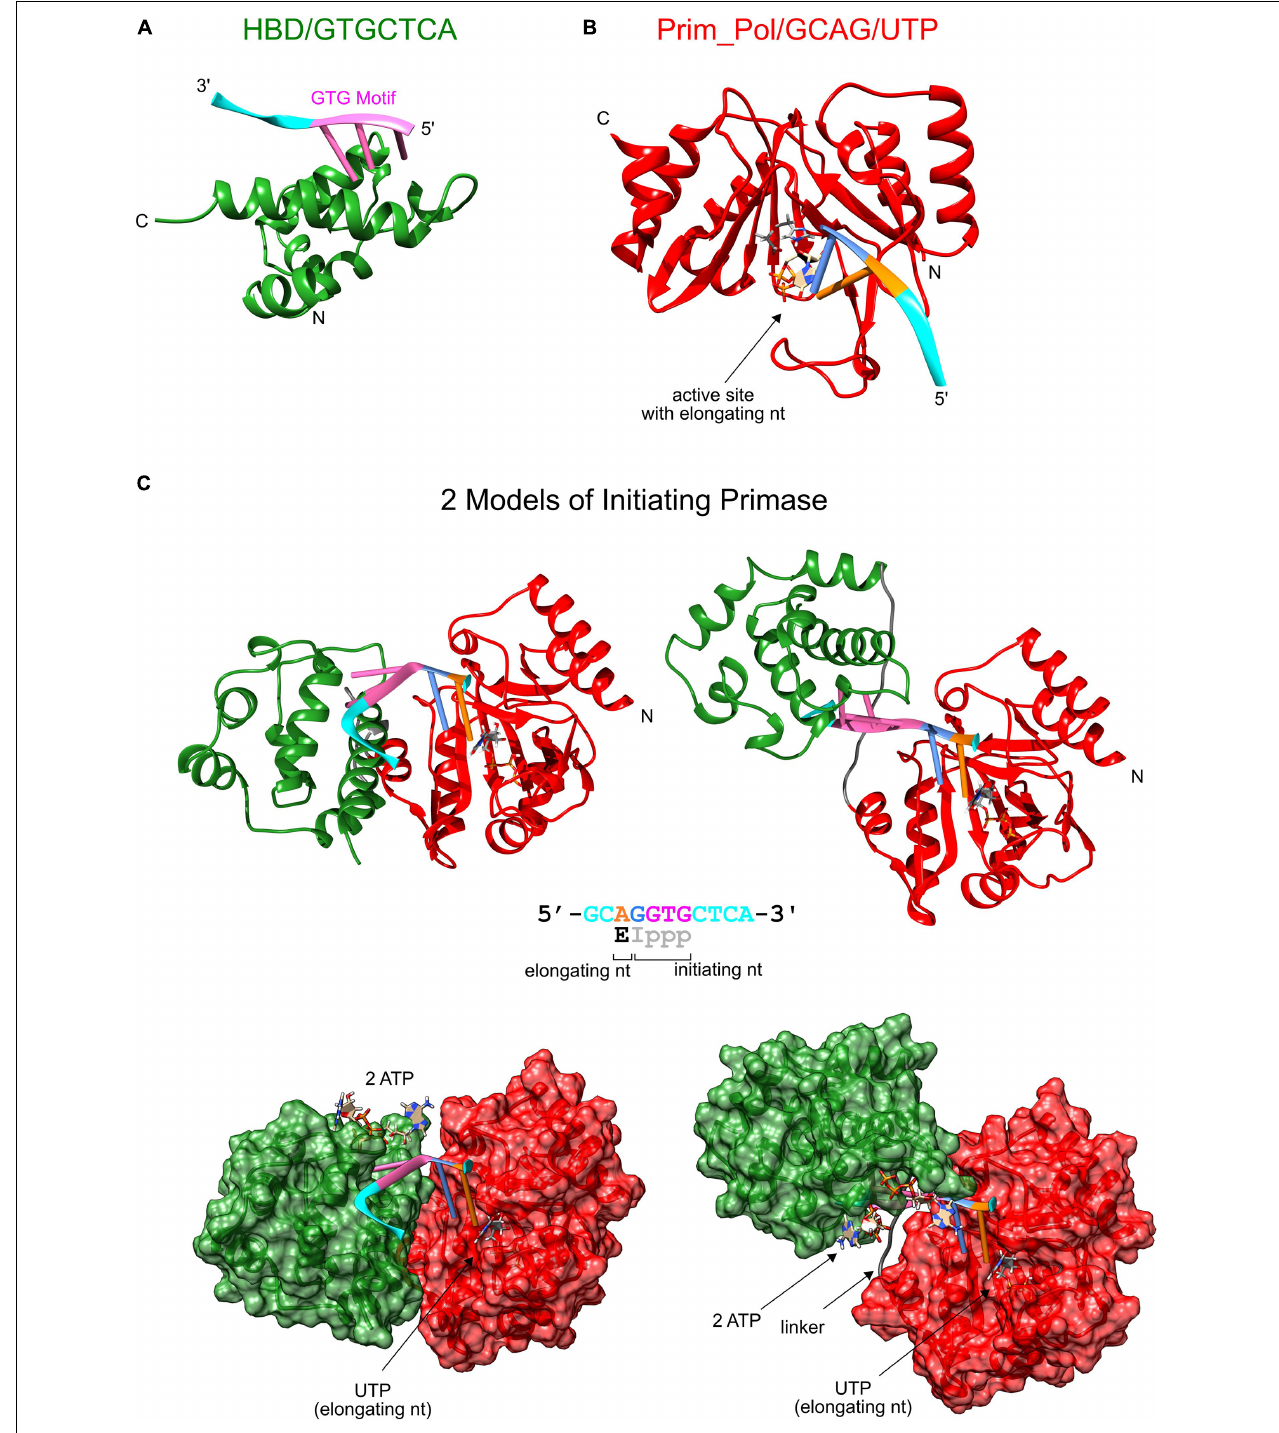
FIGURE 5 | Structure model of the initiating primase. (A) Solution structure of the HBD domain (green) binding sequence-specifically a template with a GTG motif (pdb: 6GVT), (B) Model of catalytic Prim_Pol domain (red, pdb: 3M1M) complexed with template and UTP at the elongating position (derived from M. tuberculosis PolDom (pdb: 4MKY and 3PKY) having the same conserved active site). (C) Two models of the complete primase during initiation of primer synthesis. The two models were obtained by rigid body docking between the protein complexes of Prim_Pol/GCAG and HBD/GTGCTCA while enforcing a covalent bond between the two terminal guanosines and modeling a flexible linker between both domains. The dinucleotide is formed opposite of the two bases upstream of the GTG motif and constrains the possible conformations of the initiating primase as the GTG remains bound to the HBD domain and dinucleotide formation is catalyzed at the active site of the Prim_Pol